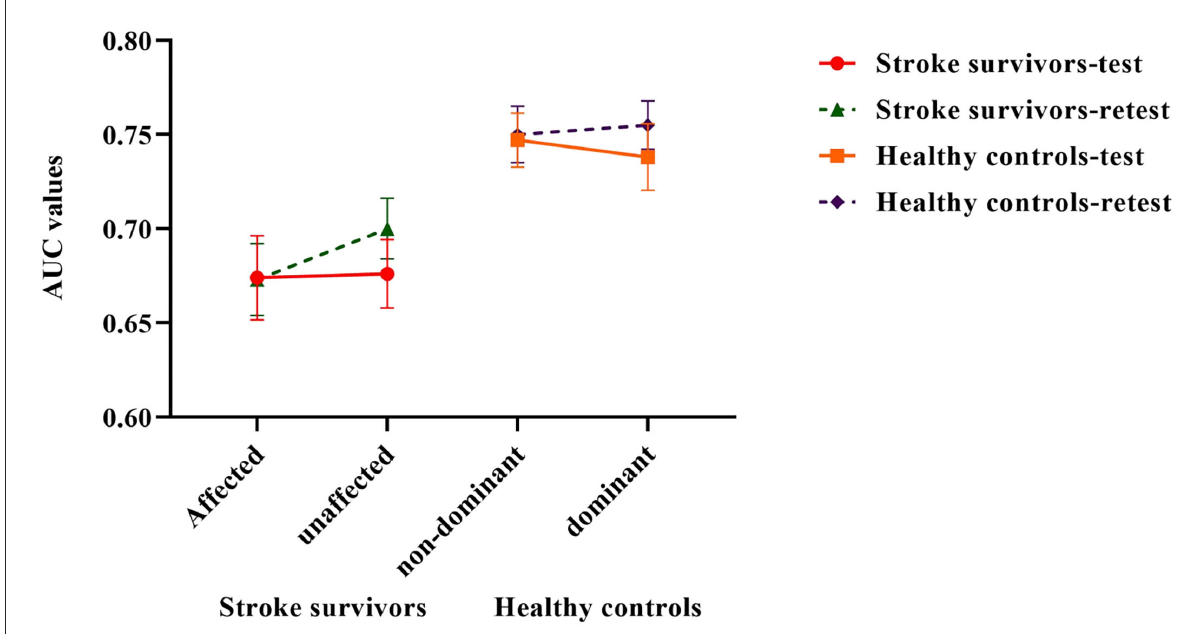
FIGURE2 Ankle proprioceptive acuity scores in stroke survivors and healthy controls. Error bars represent standard errors of the